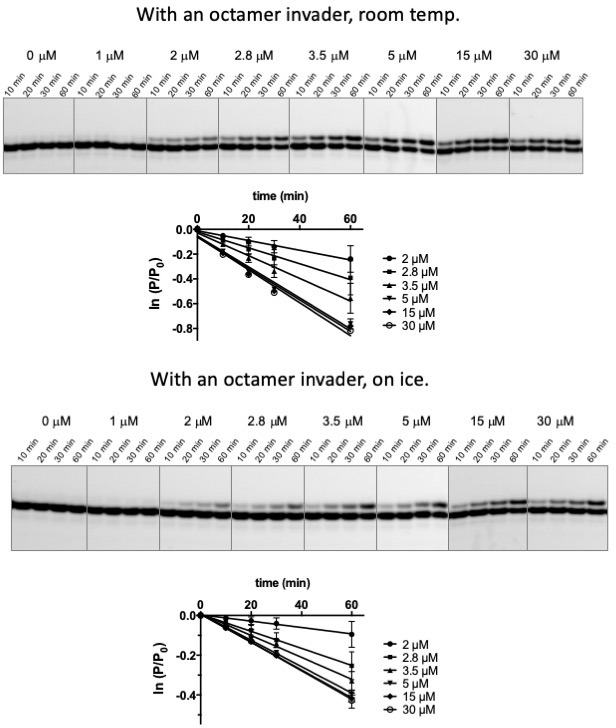
Representative denaturing PAGE data and plots of ln(P/P0) vs. time for the reaction kinetics with an octamer invader, as described in Figure 2.